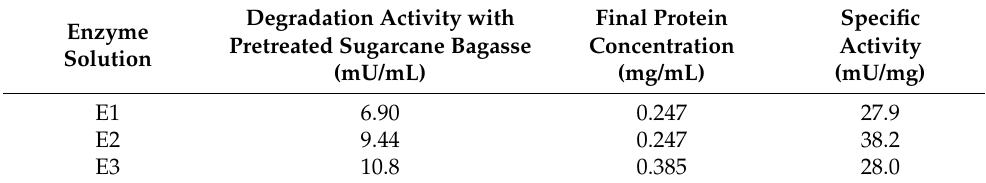
Figure 7. Enzymatic activities of 30-pass-treated sugarcane bagasse as a substrate using each enzyme solution. Enzyme solutions: E1, enzyme solution from pretreated sugarcane bagasse medium (rhombus); E2, enzyme solution from untreated sugarcane bagasse medium (square); and E3, enzyme solution from cellobiose medium (triangle). Negative control (cross). Table 2. Degradation activity of 30-pass-treated sugarcane bagasse for 12 h